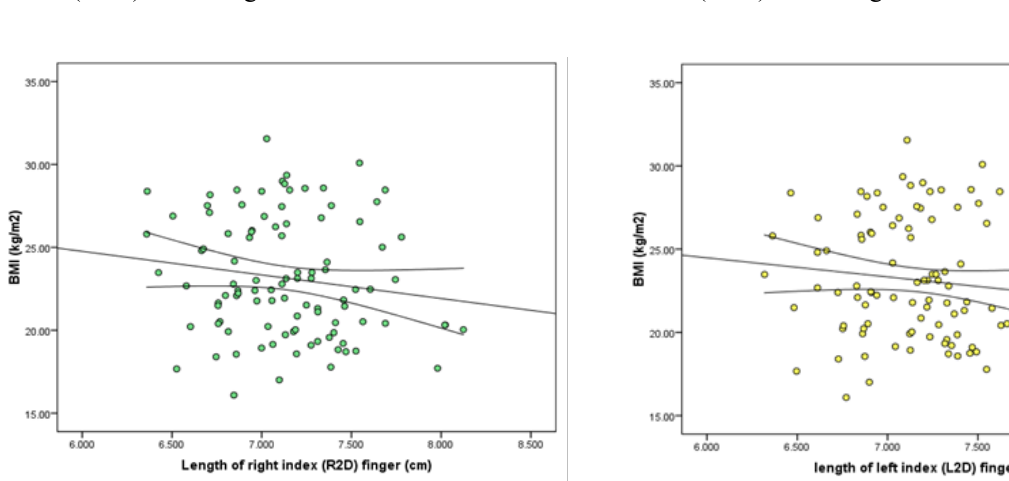
Fig 6. Correlation of length of left index finger (R2D) with